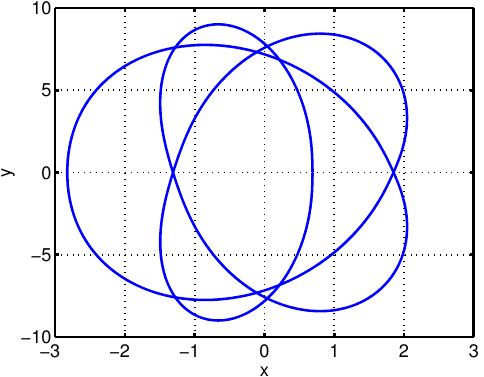
Fig. 1 Periodic orbit located at x = 0 . 69, T = 165 for C = 1 . 92, and µ = 0 .